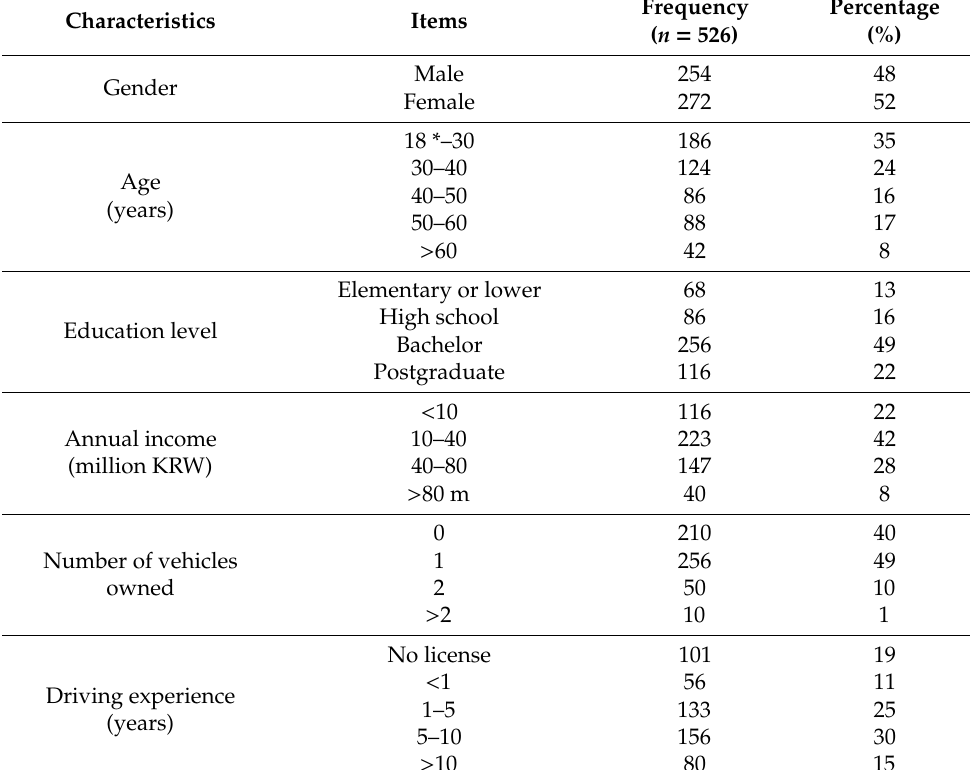
Table 2. Demographics of